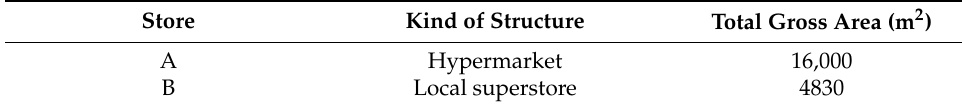
Table 4. Main geometrical data about the two stores under analysis.